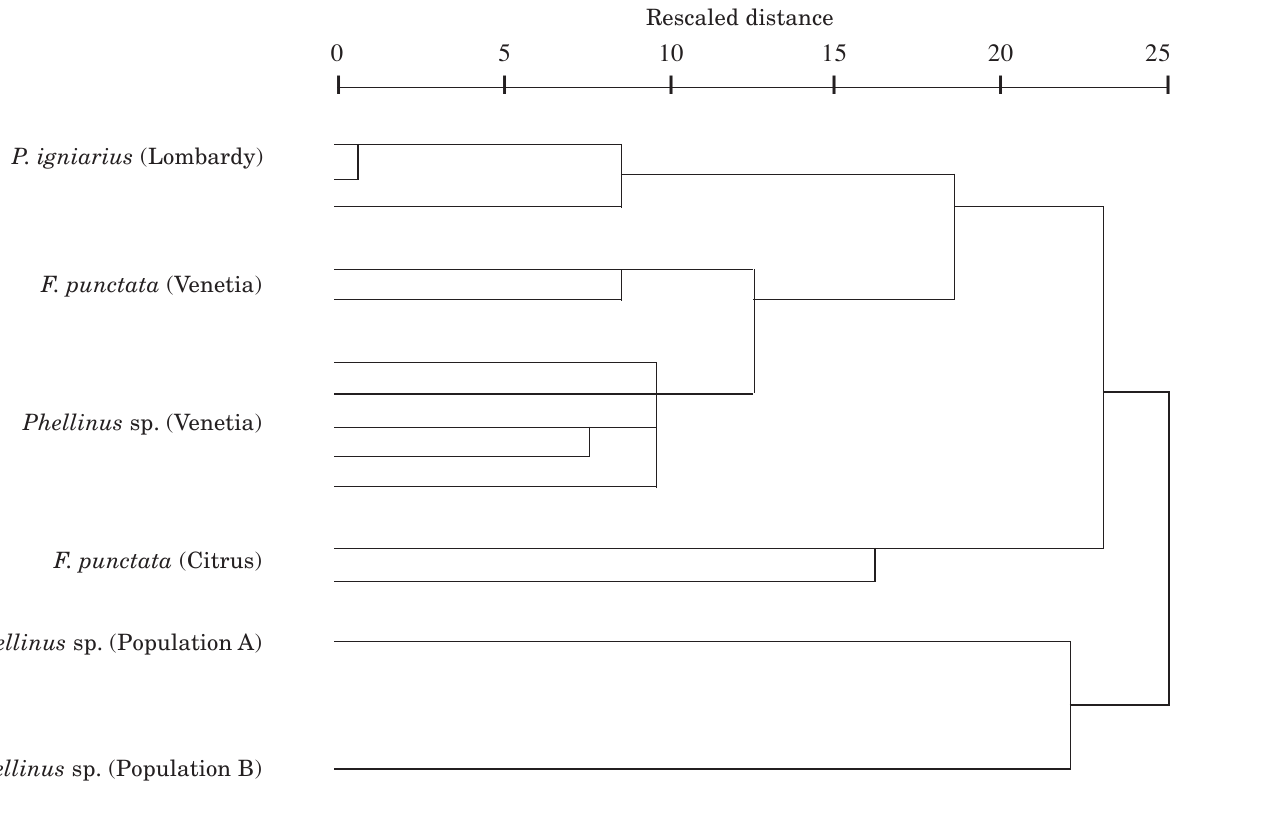
Fig. 2. Dendrogram from cluster analysis of genetic distance among